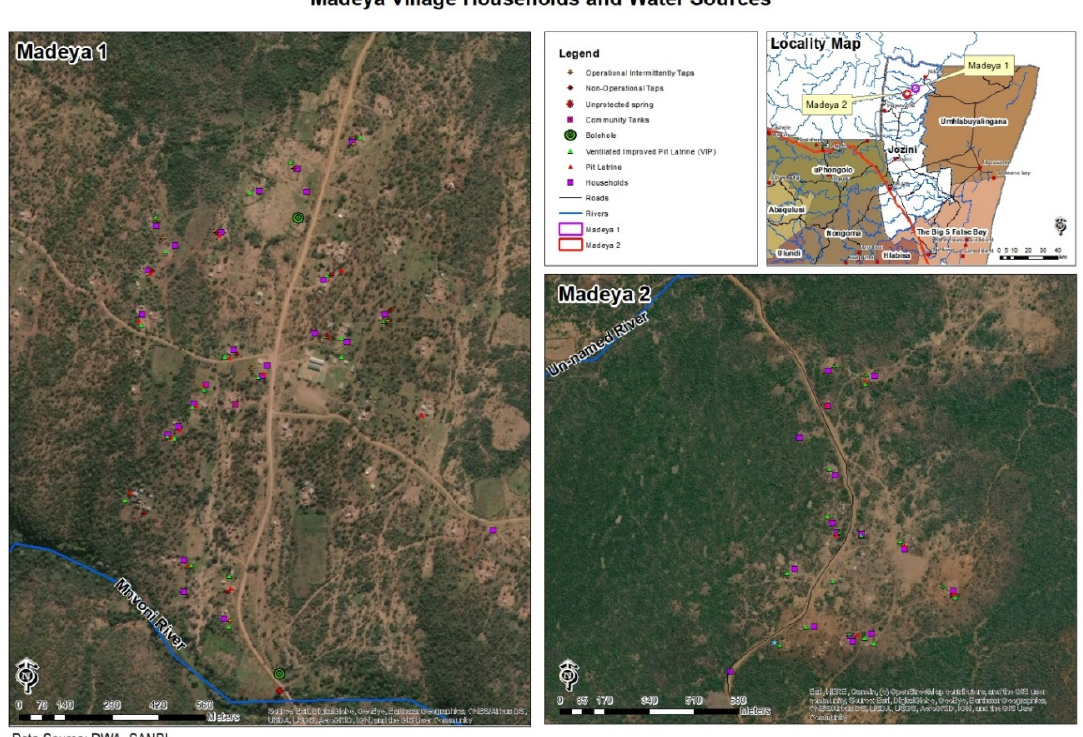
Figure 1. Aerial and coordinate map of the households included in the Madeya Village, the study area.